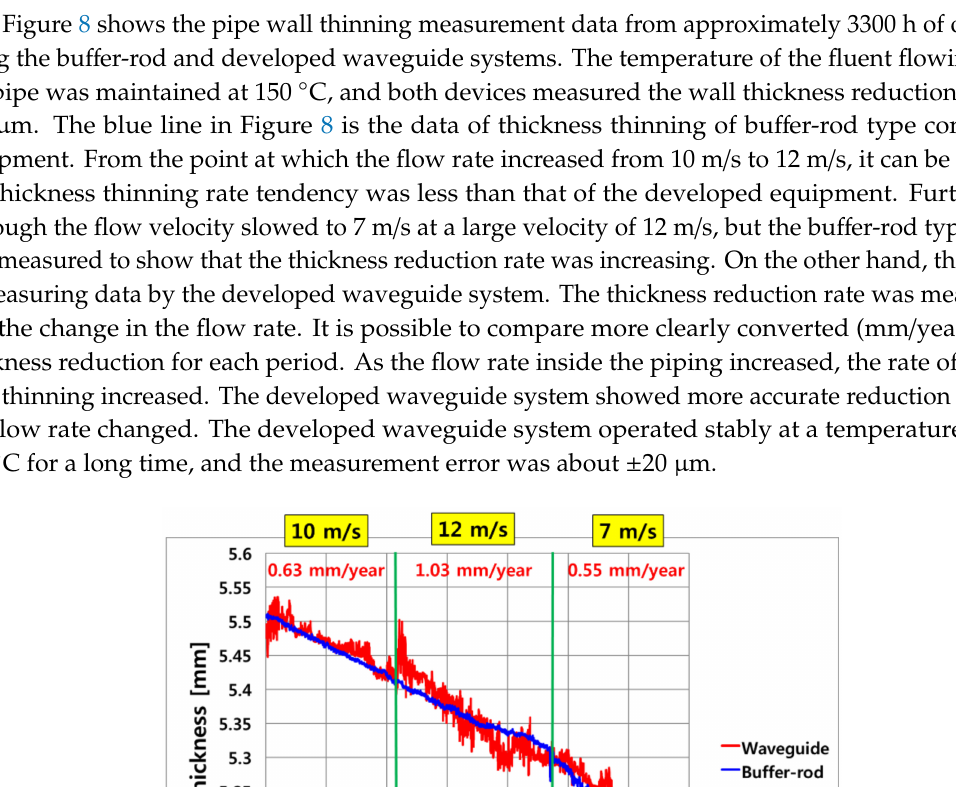
Figure 7. Pipe wall-thickness monitoring of carbon steel piping in the flow accelerated corrosion proof test facility: Di ff erent wall-thinning ratios observed depending on the flow velocities.